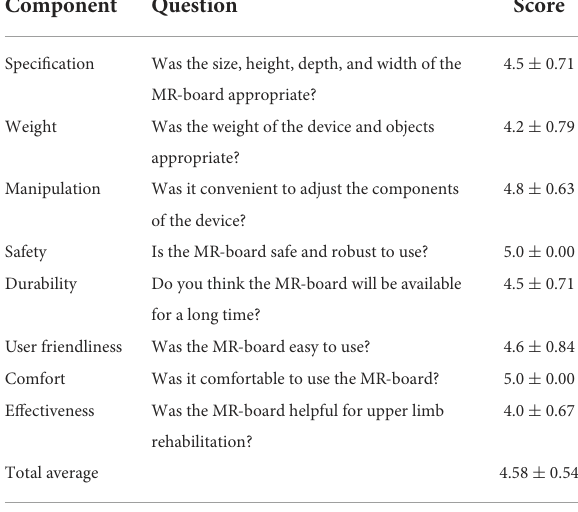
TABLE 2 Usability test of the mixed reality-based rehabilitation board (MR-board) in eight domains.